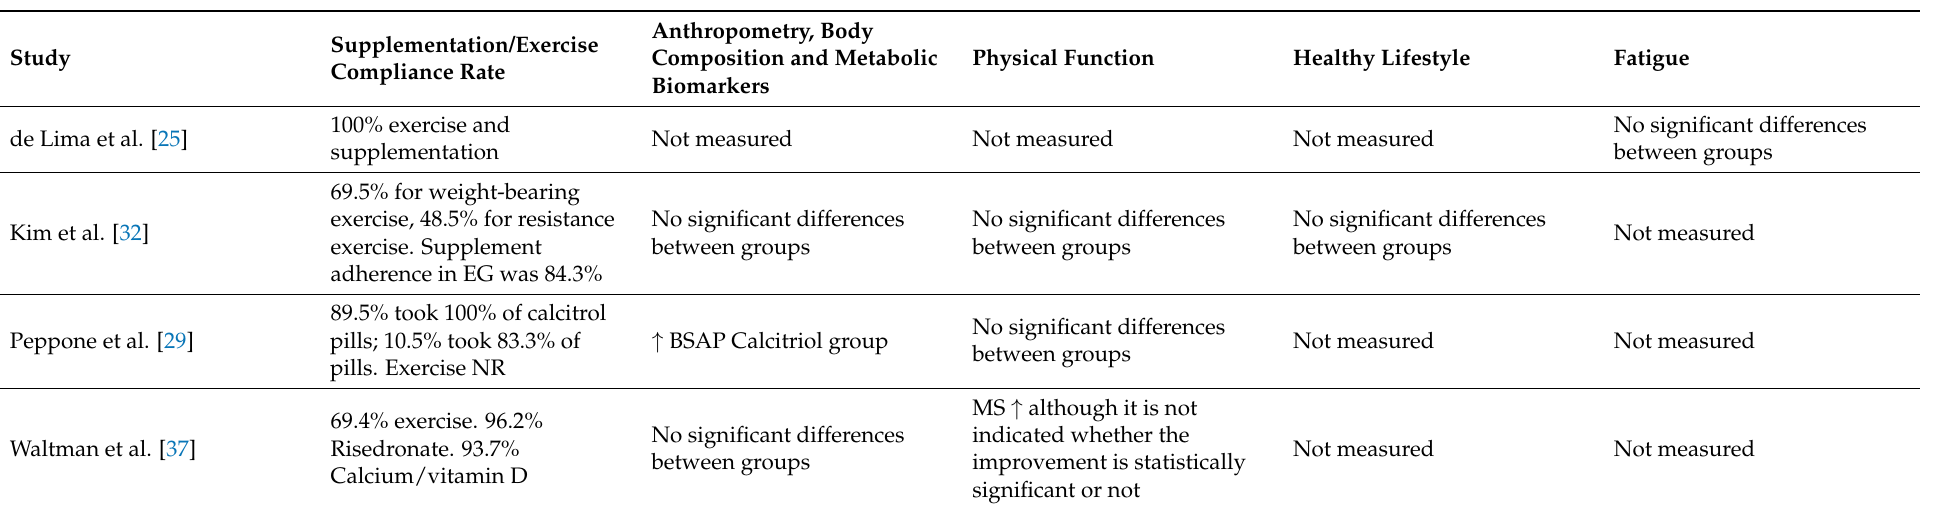
Table 5. Results of studies with exercise plus supplementation intervention.